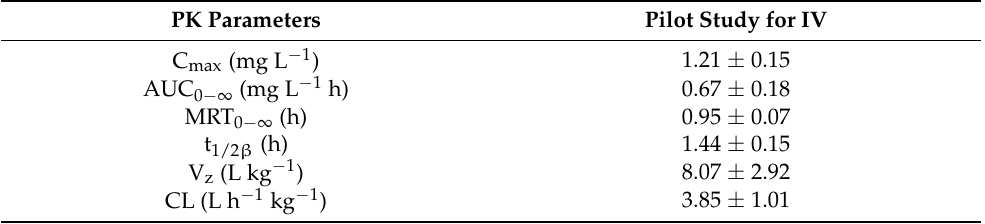
Table 3. Pharmacokinetic parameters after intravenous administration of the DMSO/saline solution of CCG-211790 at a dose of 2.5 mg/kg in male Sprague–Dawley rats ( n = 2).